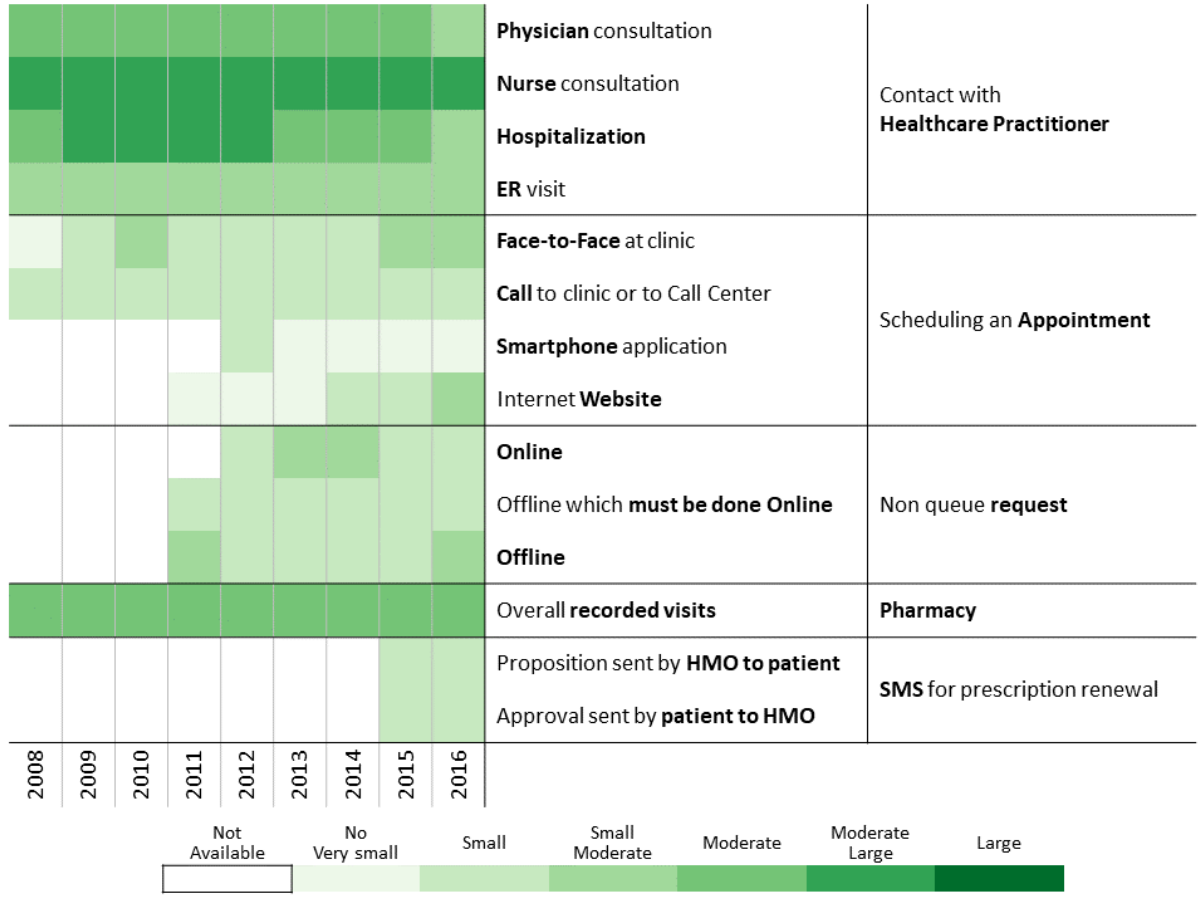
Figure 12. Communication pattern changes for patients with diabetes having measured human contacts mainly by consulting